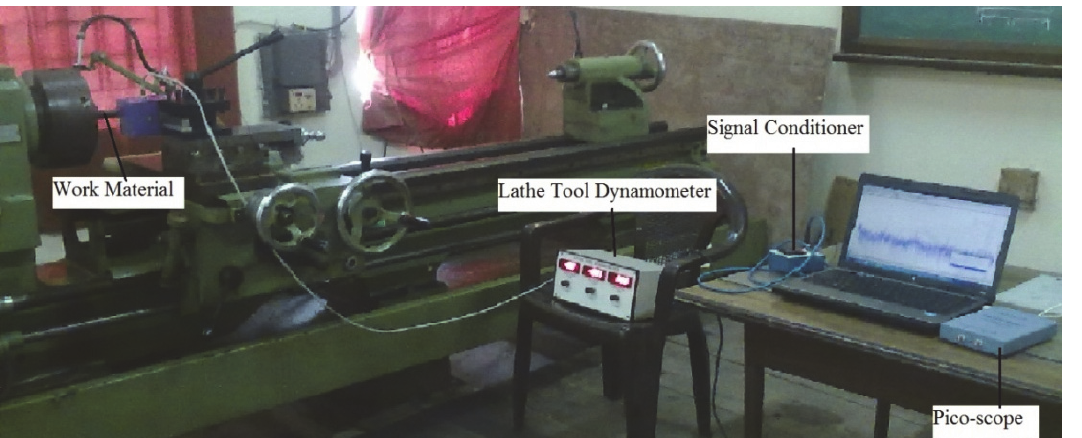
Fig. 1. Experimental Setup